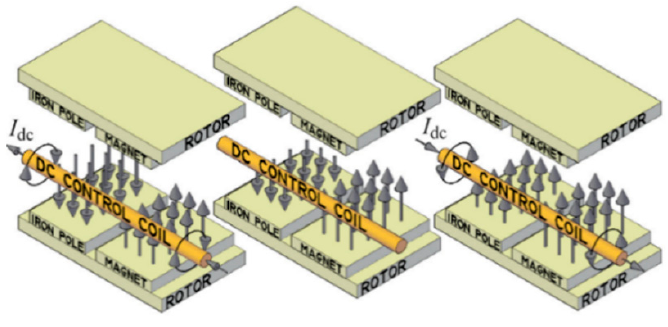
Figure 8. Main principle of the HEAFM.